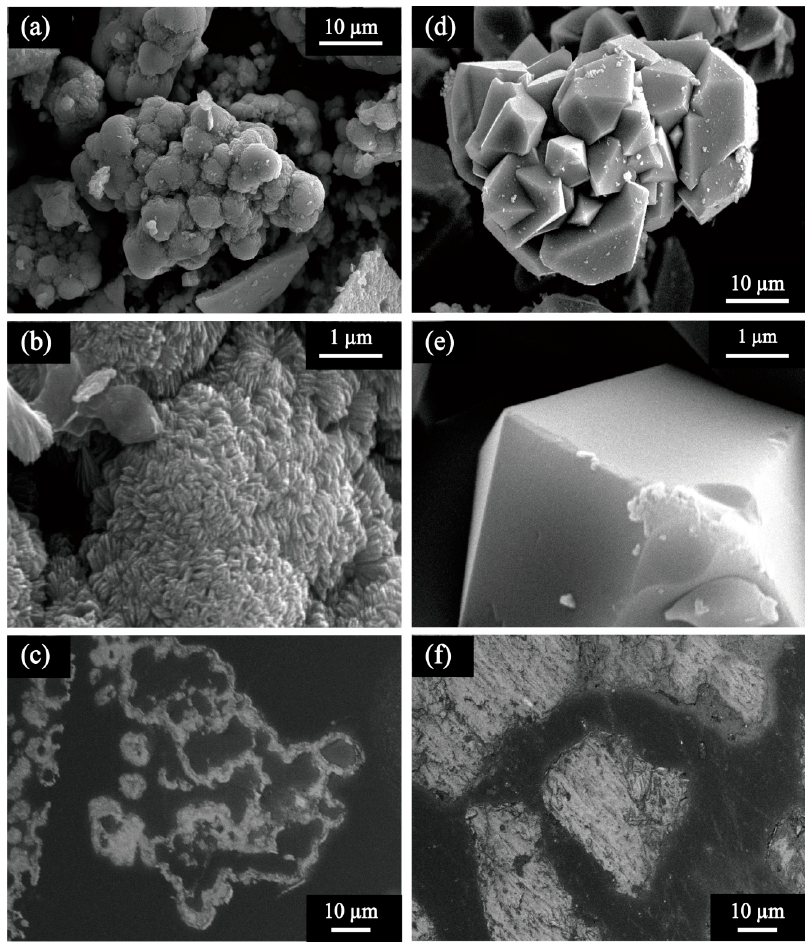
Figure 2. SEM images of ( a – c ) bio- and ( d – f ) chemical- scorodite seed crystals at 2000× ( a , d ) or 20,000× ( b , e ) magnification. Cross-section views are shown at 3000× magnification ( c , f ). Table 1. Particle size and specific surface area of bio- and chemical- scorodite seed crystals. Particle Size ( µ Seed Crystal